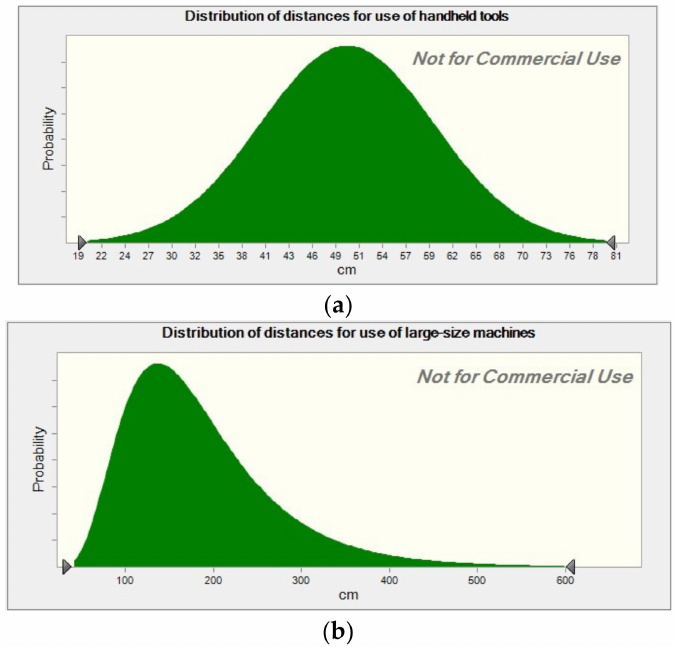
Figure 1. ( a ) Distance setting for curve saw, orbit sander, router trimmer, drill machine, and nail gun; ( b ) Distance setting for circular saw, pillar drill machine, and air